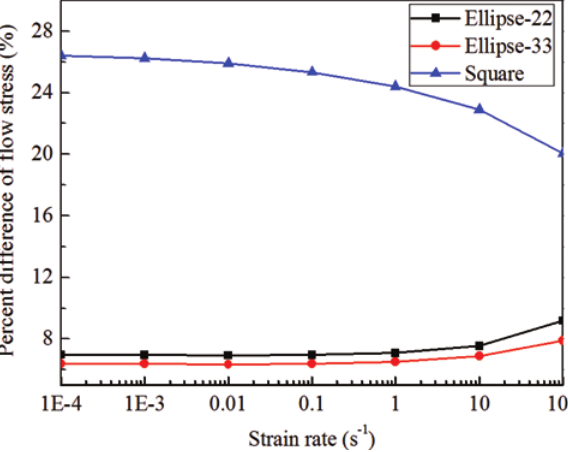
Figure 14: Percent difference changing with the strain rates for square and elliptical